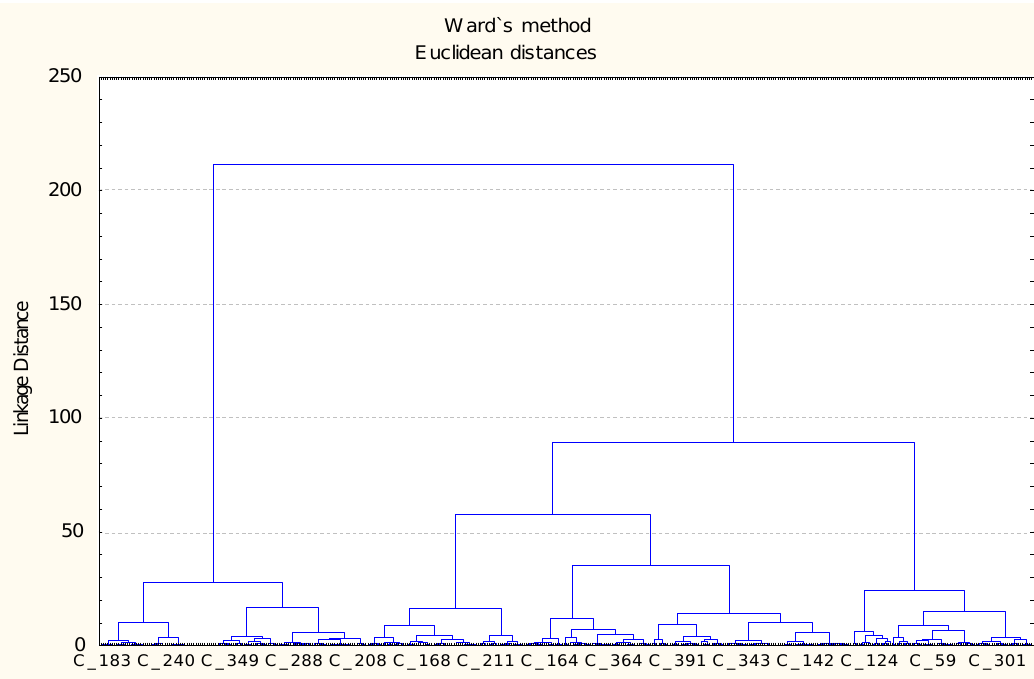
Figure 2: Five cluster solution: Ward’s method with Squared Euclidean distance measures Ward`s method Euclidean